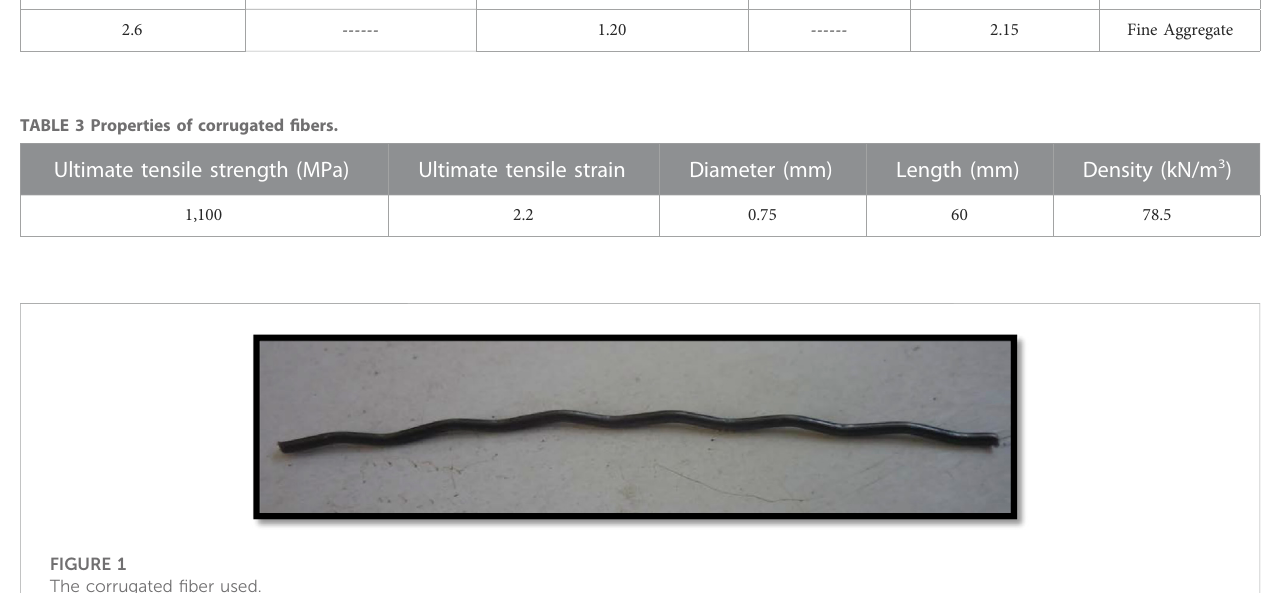
FIGURE 1 The corrugated fi ber used.